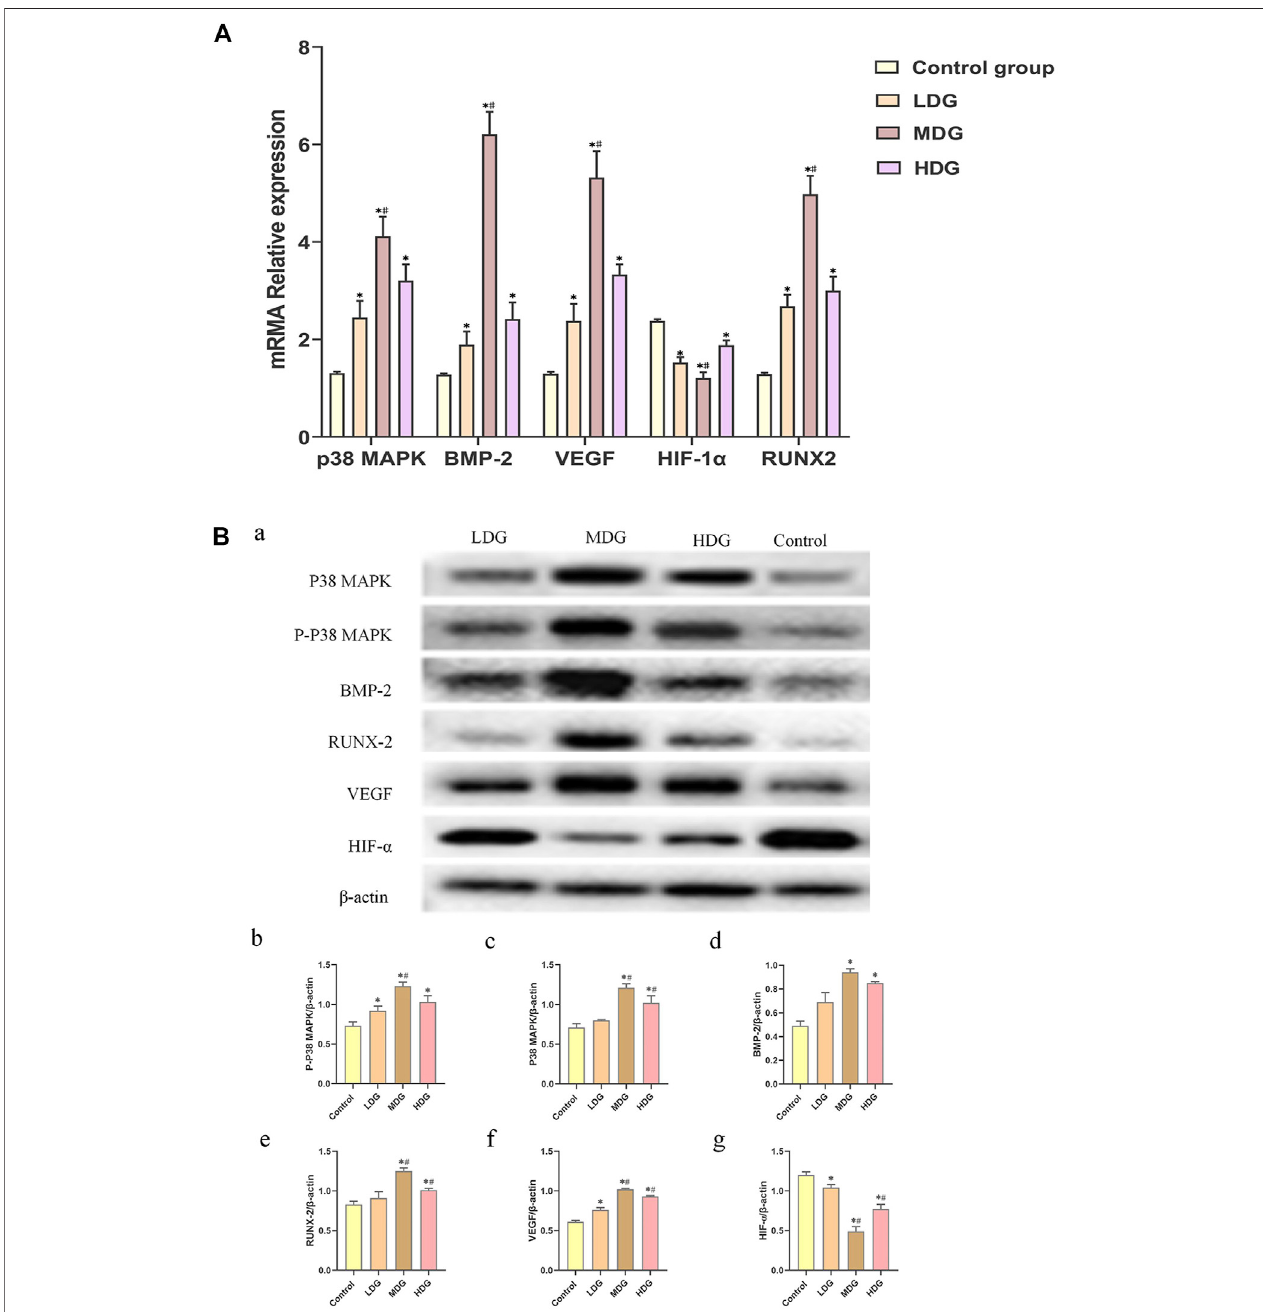
FIGURE 9 | The expressions of p38 MAPK, BMP-2, VEGF, HIF-1 α , and RUNX-2 mRNA on BMSCs by quantitative real-time PCR. The data are expressed as the mean ± SEM of three independent experiments. * p < 0.05 vs. control group, # p < 0.05 vs. the TFDR low dosage group, TFDR high dosage group. (B) (a) p38 MAPK, p-p38 MAPK, BMP-2, RUNX-2, VEGF, and HIF-1 α protein expression on BMSCs detected by western blot analysis. (b) – (g) were statistical analysis of (a). The data are expressed as the mean ± SEM of three independent experiments. * p < 0.01 vs. the Control group; # p < 0.01 vs. the TFDR low dosage group.